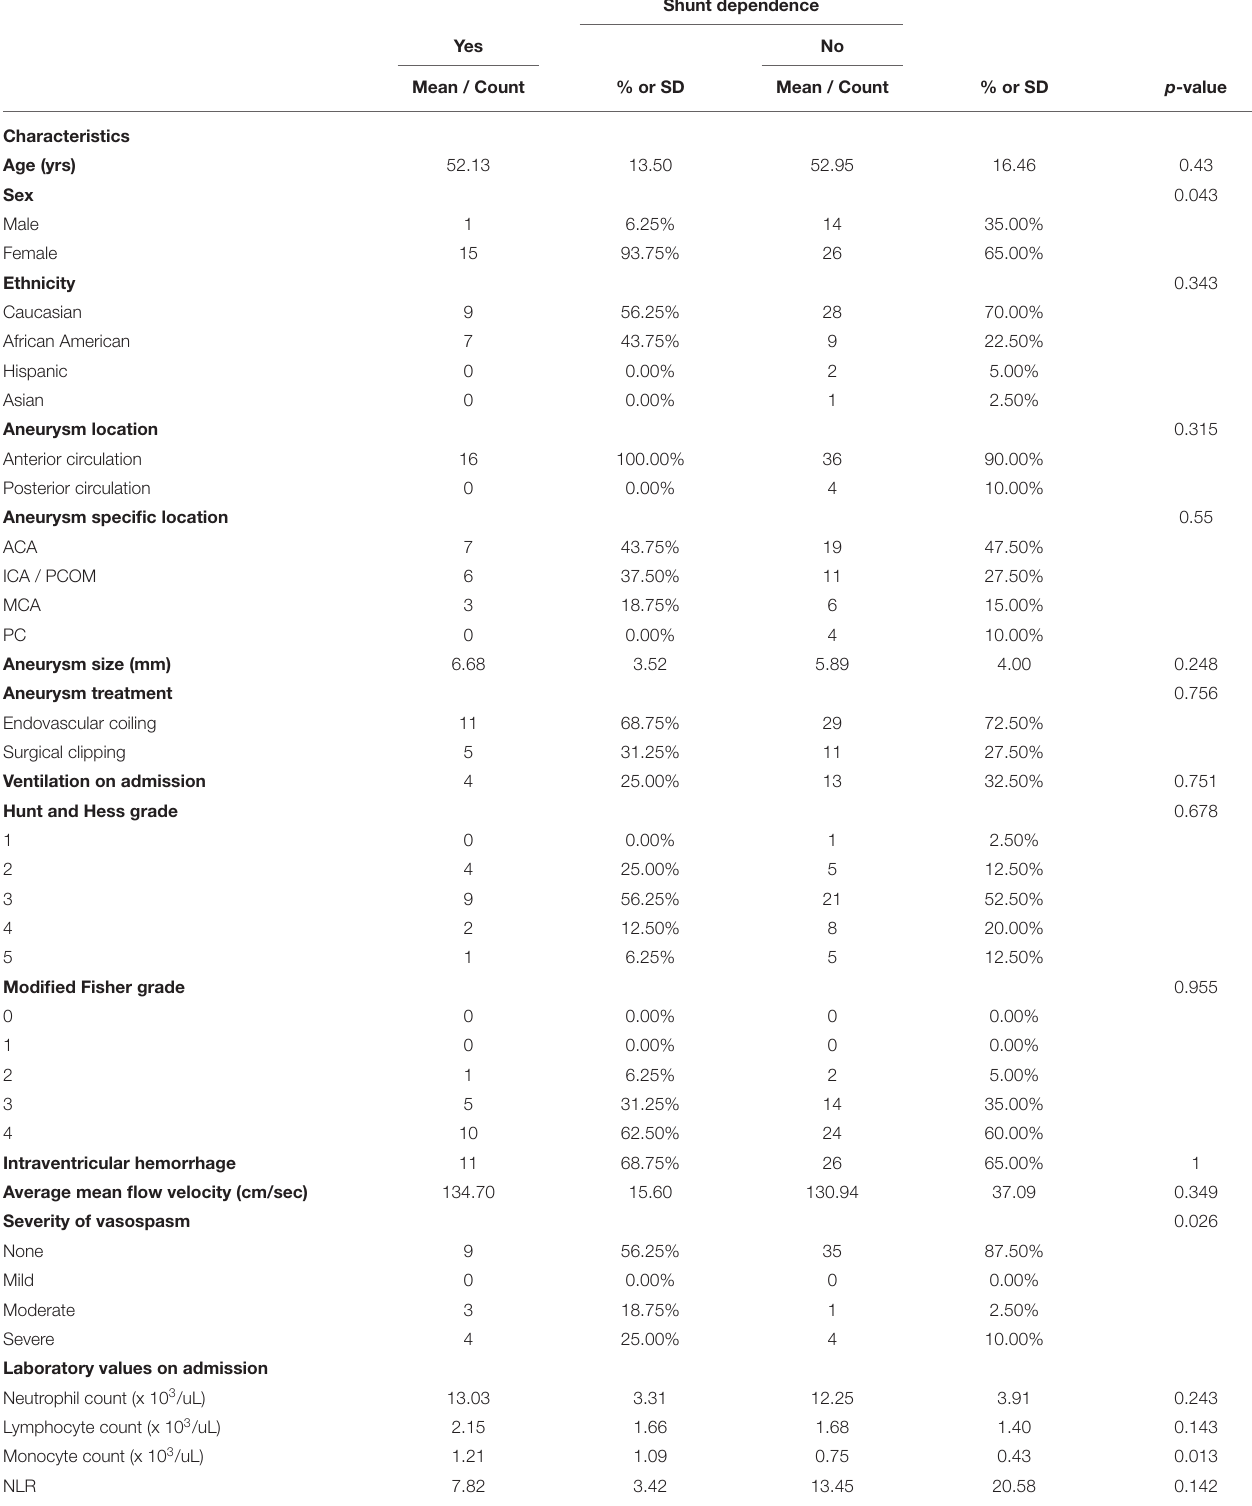
TABLE 5 | Sub-cohort univariate analysis of predictors of shunt dependence after aneurysmal subarachnoid hemorrhage in patients with acute hydrocephalus. Shunt